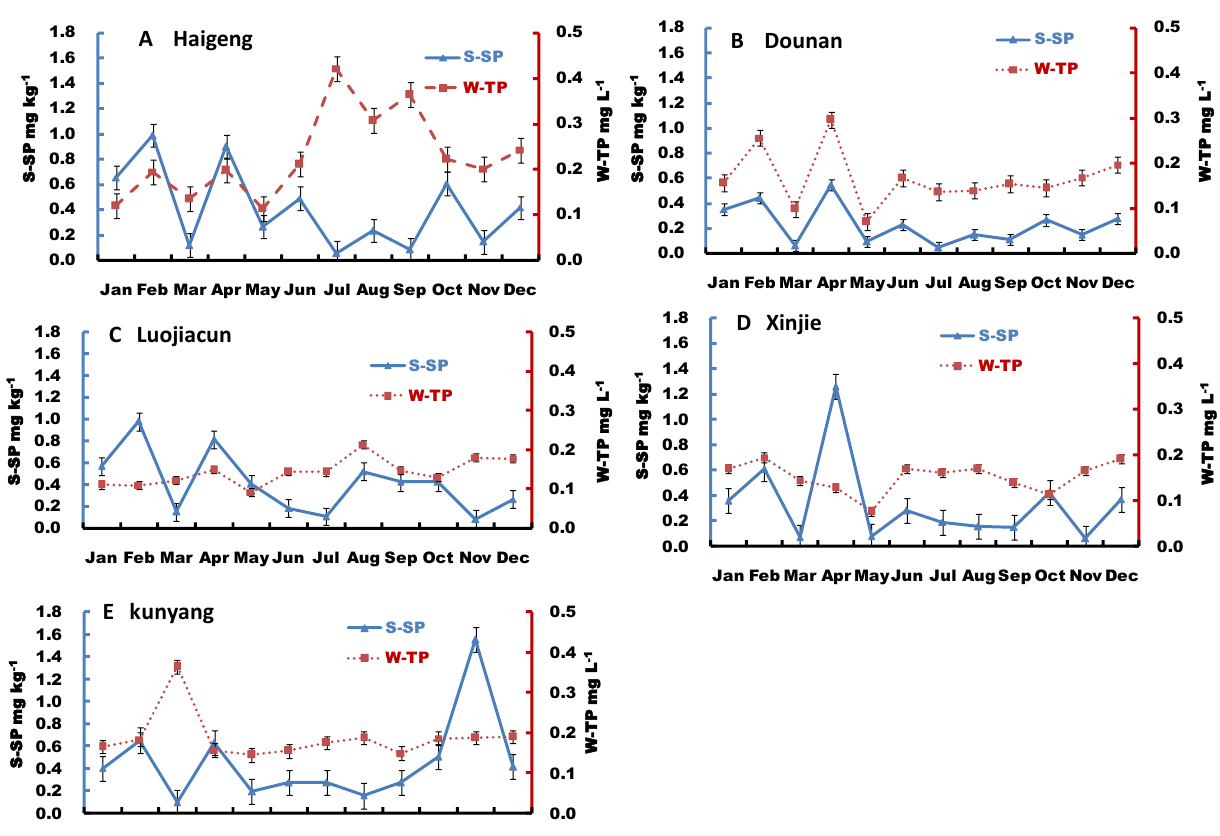
Figure 5. ( A – E ) Sediment soluble-P (S-SP) (0–5 cm) and water total phosphorus (W-TP) at the sediment–water interface of Dianchi Lake. 3.5. Relationships between Sediment Available-P, Soluble-P, and Chlorophyll-a Concentrations in Dianchi Lake The sediment available-P was significantly positively correlated with Chlorophyll-a concentrations (Figure 6A; r = 0.40, p < 0.01, n = 60), but the sediment soluble-P was significantly negatively correlated with Chlorophyll-a concentrations (Figure 6B; r = 0.36, p < 0.01, n = 60).